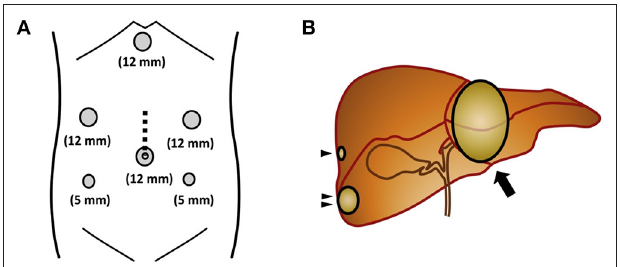
FIGURE 3 | (A) The surgical trocar sites. The dotted line indicates the incision line used for the hand-assisted laparoscopic procedure, which was 7-cm long. (B) Liver scheme. Arrowhead, a tumor measuring 5mm was found in the right hepatic lobe (segment 7); Double arrowhead, another tumor was detected in the right hepatic lobe (segment 6); Arrow, a third metastatic tumor was observed in the left hepatic lobe (segments 2/3). From Ito et al. (32).